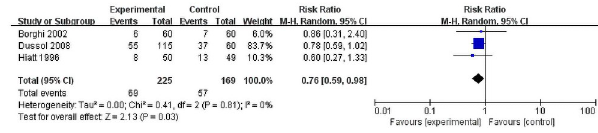
Fig 5. Forest plot for the meta-analysis of withdraw